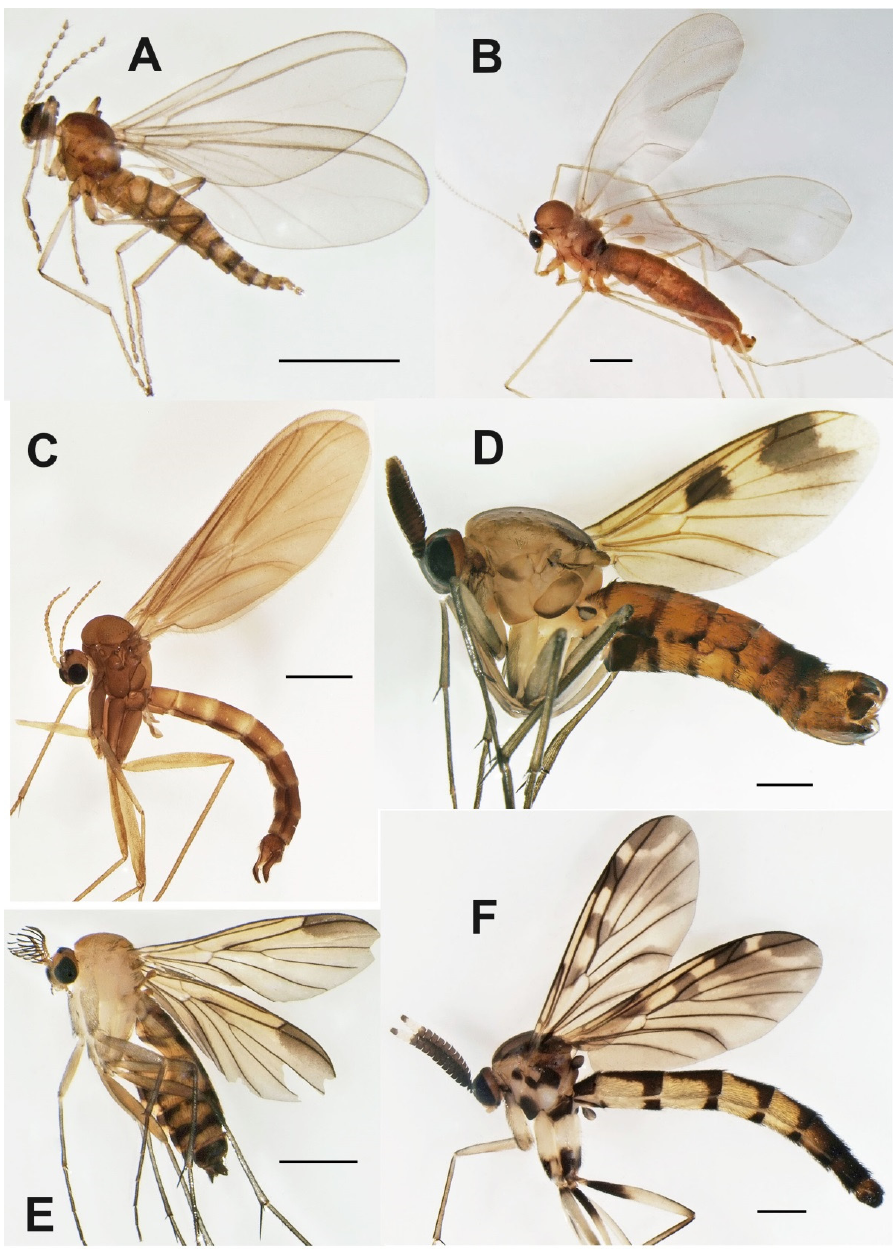
Figure 3. Habitus photographs of new extant species. ( A ) Catocha jingfui sp. nov. (paratype, female); ( B ) Planetella taiwanensis sp. nov. (holotype, male); ( C ) Ditomyia asiatica sp. nov. (paratype, male); ( D ) Euceroplatus mantici sp. nov. (holotype, male); ( E ) Platyceridion yunfui sp. nov. (paratype, female); ( F ) Terocelion adami sp. nov. (holotype, male). Scale bars: 1 mm. All photos by J. Šev č ík.